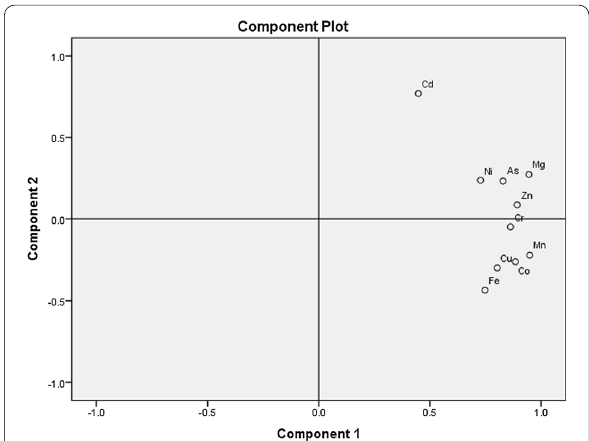
Fig. 2 Principal component profile of the ten trace metals collected from the sediments of the selected sampling